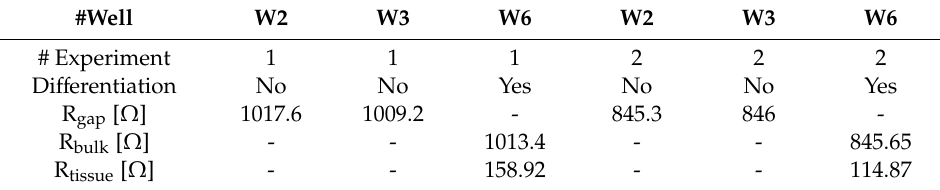
Figure 8. Electrical model of the cell culture and electrode system in differentiated wells. Electrical model of the differentiated tissue [18]. Table 2. R gap, R bulk, and R tissue obtained in the different wells in both monitored experiments .